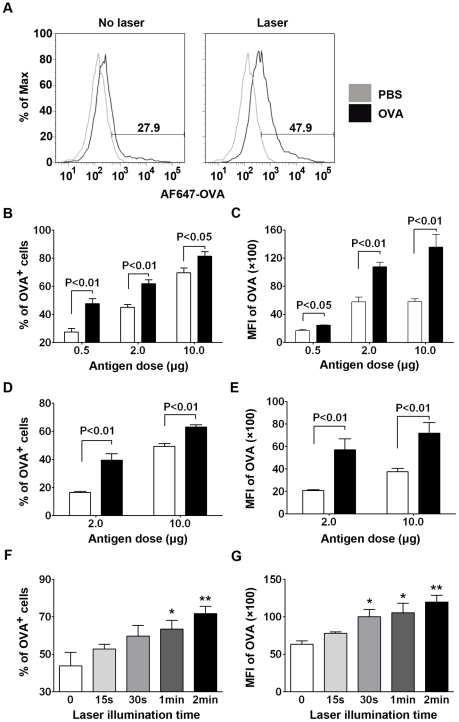
Laser enhances Ag-uptake by DCs in the skin.
A. Representative flow cytometry histograms showing percentages of OVA+ CD11c+ cells. Single cell suspension was prepared from full thickness of the skin 6 hrs after 0.5 µg AF647-OVA in 20 µl or 20 µl PBS was i.d. administrated into the site of laser illumination or control. The cells were stained with anti-CD11c antibody, and analyzed for percentages of OVA+CD11c+ cells on the gated CD11c+ cell population. Percentages of OVA+ CD11c+ cells (B and D) and mean fluorescence intensity (MFI) of AF647-OVA (C and E) were analyzed at 6 hr (B and C) or 24 hr (D and E) after i.d. administration of AF647-OVA at the indicated doses. n = 6, blank bar, AF647-OVA alone; and black bar, laser + AF647-OVA. F and G. A light dose-dependent increase in Ag-uptake by DCs. The lower dorsal skin of mice was illuminated with laser at 0.3 W for the indicated time, corresponding to a light dose of 11.3, 22.5, 45, or 90 J/cm2, respectively. AF674-OVA at 2 µg/ mouse was injected into the laser-illuminated site and 6 hrs later, percentages of OVA+ CD11c+ cells (F) and MFI of AF647-OVA (G) were analyzed and expressed as above.* and **, p<0.05 and 0.01, respectively.